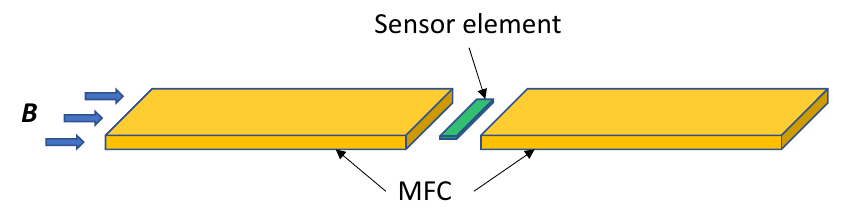
Figure 1. Schematic representation of a typical magnetic sensor with MFCs.